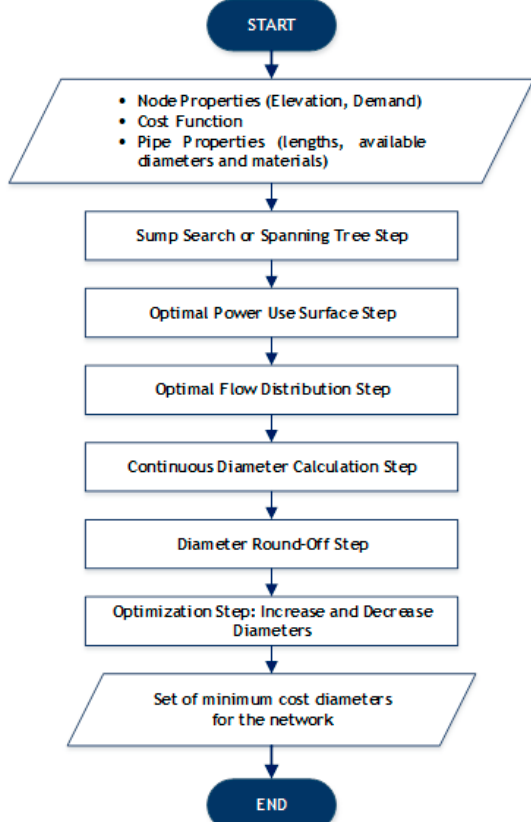
Figure 2. Optimal Power Use Surface (OPUS) methodology flow chart.